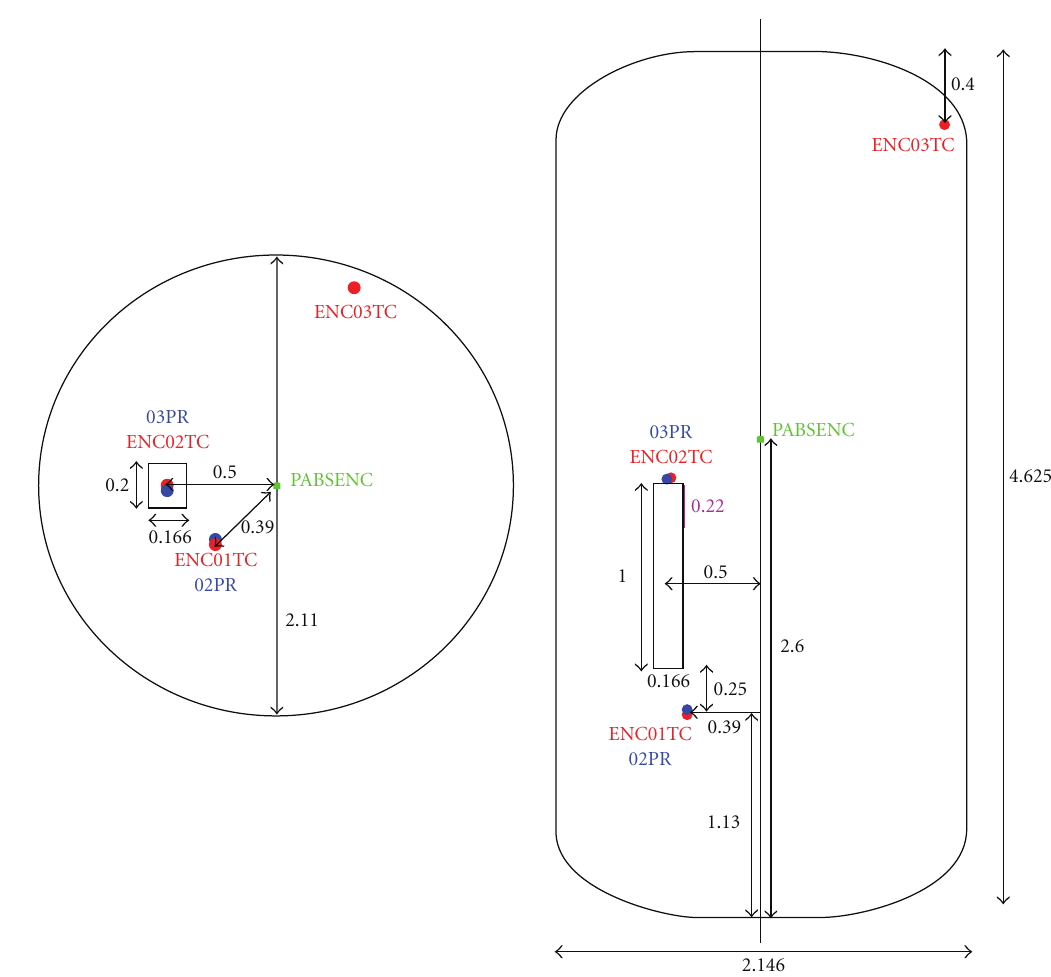
Figure 7: Sketch of the computational domain of the KALI-H 2